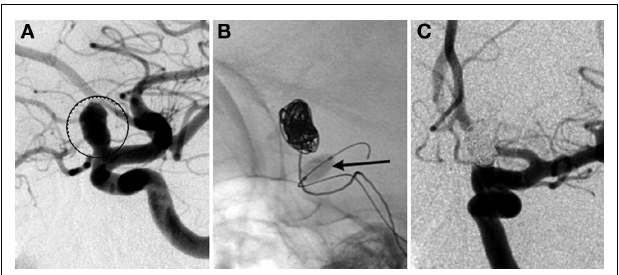
FIGURE 3 | Balloon assisted coil embolization. A 74-year-old man with a strong family history of aneurysmal SAH was found to have a left ophthalmic aneurysm. (A) Lateral view of a left ICA injection shows a 7.5-mm left ophthalmic artery aneurysm (circled) with a 4.2-mm neck.The patient underwent balloon assisted coil embolization. (B) Lateral fluoroscopic view shows the inflated balloon (arrow) with coils being deployed through a microcatheter within the aneurysm. (C) AP view of the final left ICA injection shows no residual aneurysm.